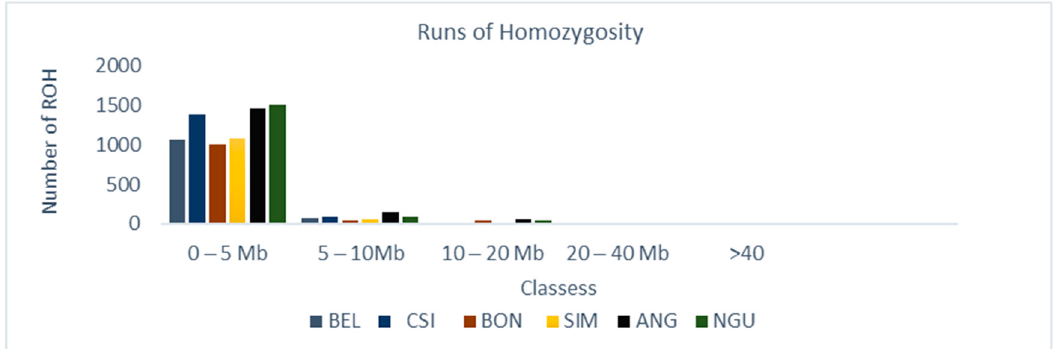
Figure 1. Classification of ROH were estimated per breed; each ROH length category and average per breed, represented from left to the right: Belgian Blue (BEL), Chinese Simmentaler (CSI), Bonsmara (BON), Nguni (NGU), South African Simmentaler (SIM), and Angus (ANG). All Breeds had the highest ROH between 0–5 Mb with the NGU and AGN showing the highest ROH 0–5 Mb on chromosomes 5, 6, 11, and 14 for SIM, and chromosomes 5, 7, and 14 for BON, respectively, in South African breeds.